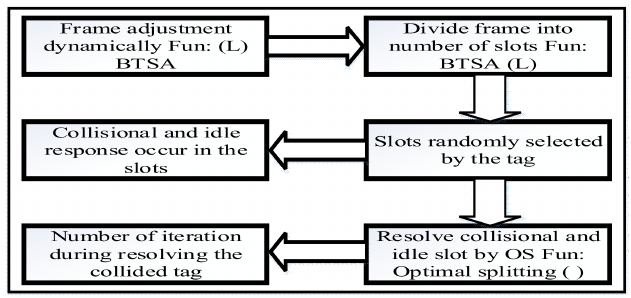
Figure 4. Process of the proposed DAF-OS